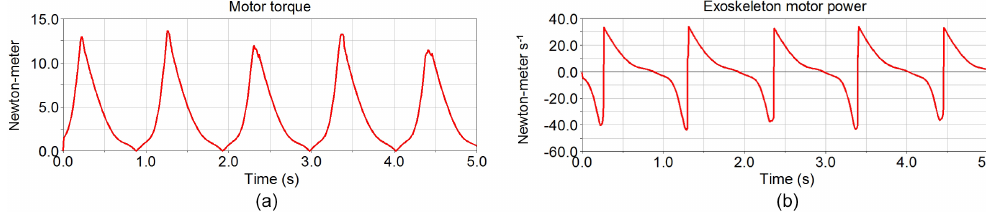
Figure 22. Computed actuator parameters: (a) z axis motor torque; (b) motor power magnitude.